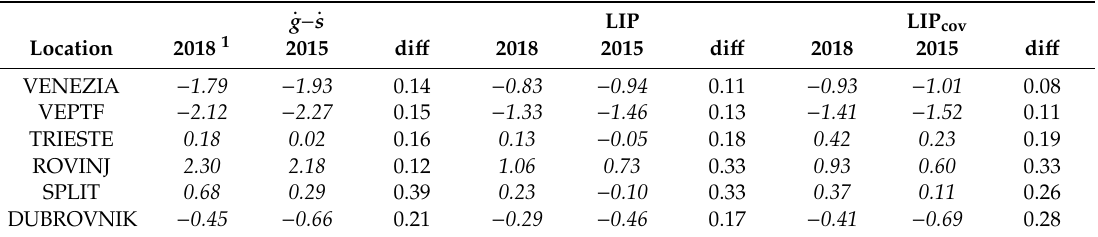
Table 7. Comparison of C3S estimated VLMs of 1993–2018 and 1993–2015. Column 1: location; columns 2, 5, 8: VLM estimated with classical, LIP, LIP cov approach in 1993–2018; columns 3, 6, 9: same for 1993–2015; columns 4, 7, 10: di ff erences between VLM estimates in the two periods. All data are in mm y − 1